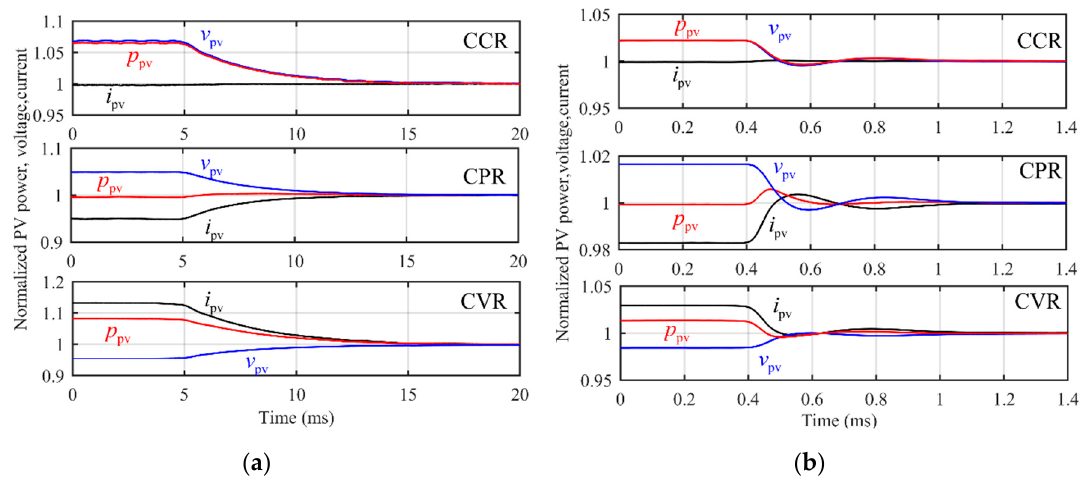
Figure 8. PV power (red), voltage (blue), and current (black) transients under ( a ) I-control and ( b ) PID-control method, when a step is applied to the input-voltage reference of the boost-power-stage converter (cf. Figure 4) in the different operational regions of the PV generator. The transient waveforms are normalized by dividing the waveforms by their final values.